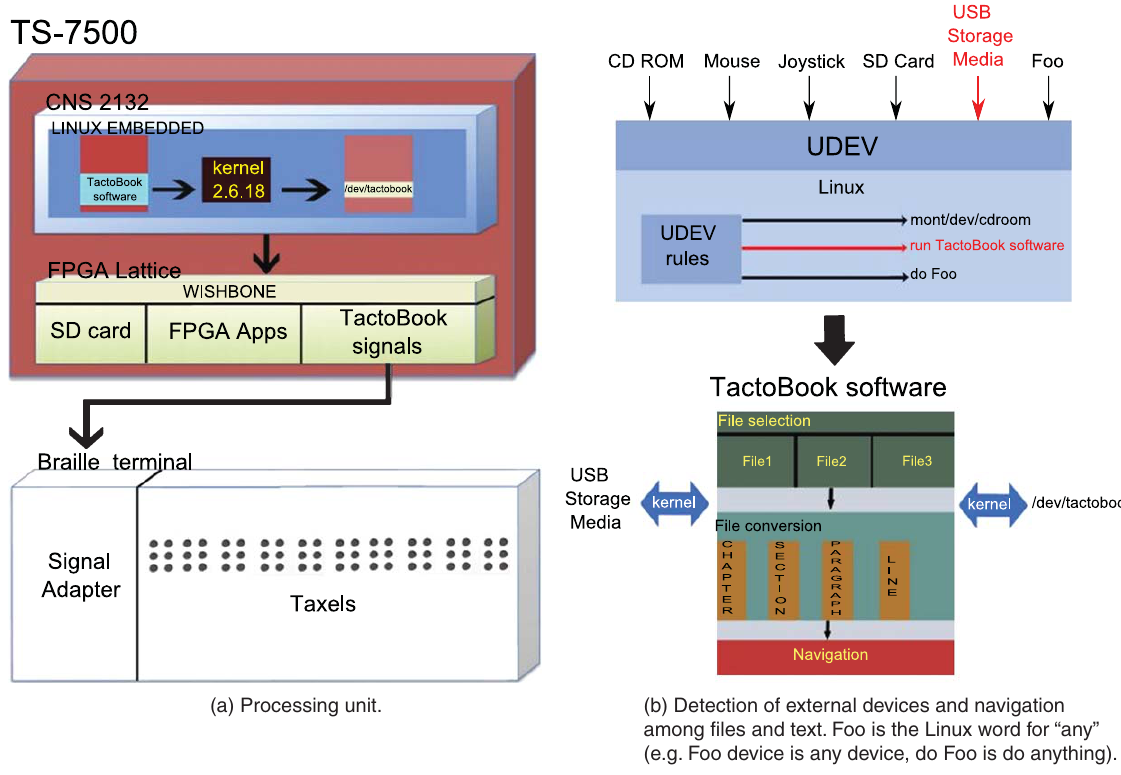
Fig. 16. The TactoBook’s Linux-based processing unit and file/text-navigation